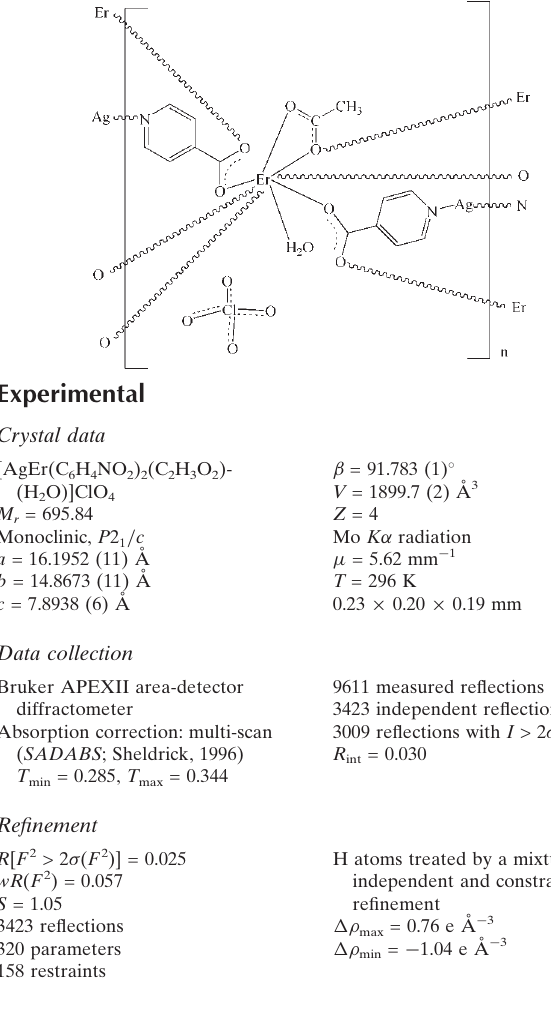
9611 measured reflections 3423 independent reflections 3009 reflections with I > 2 (cid:2) ( I ) R H atoms treated by a mixture of independent and constrained